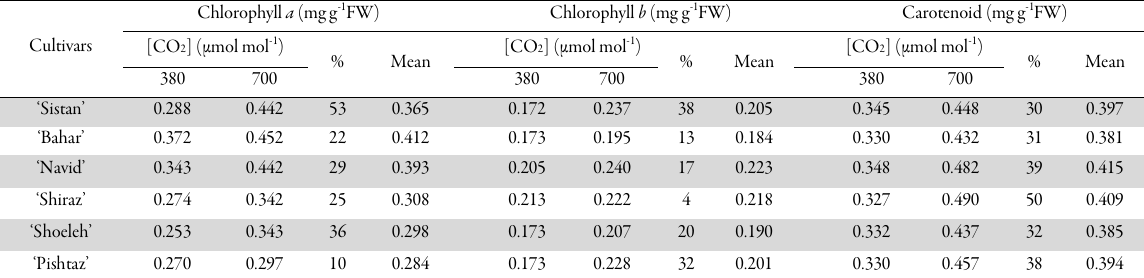
Table 3. Effects of two [CO 2 ] (380 ± 50 vs. 700 ± 50 µmol mol -1 ) on chlorophyll a (mg g -1 FW), chlorophyll b (mg g -1 FW) and carotenoid concentrations (mg g -1 FW) in the leaves of 20 Iranian bread wheat